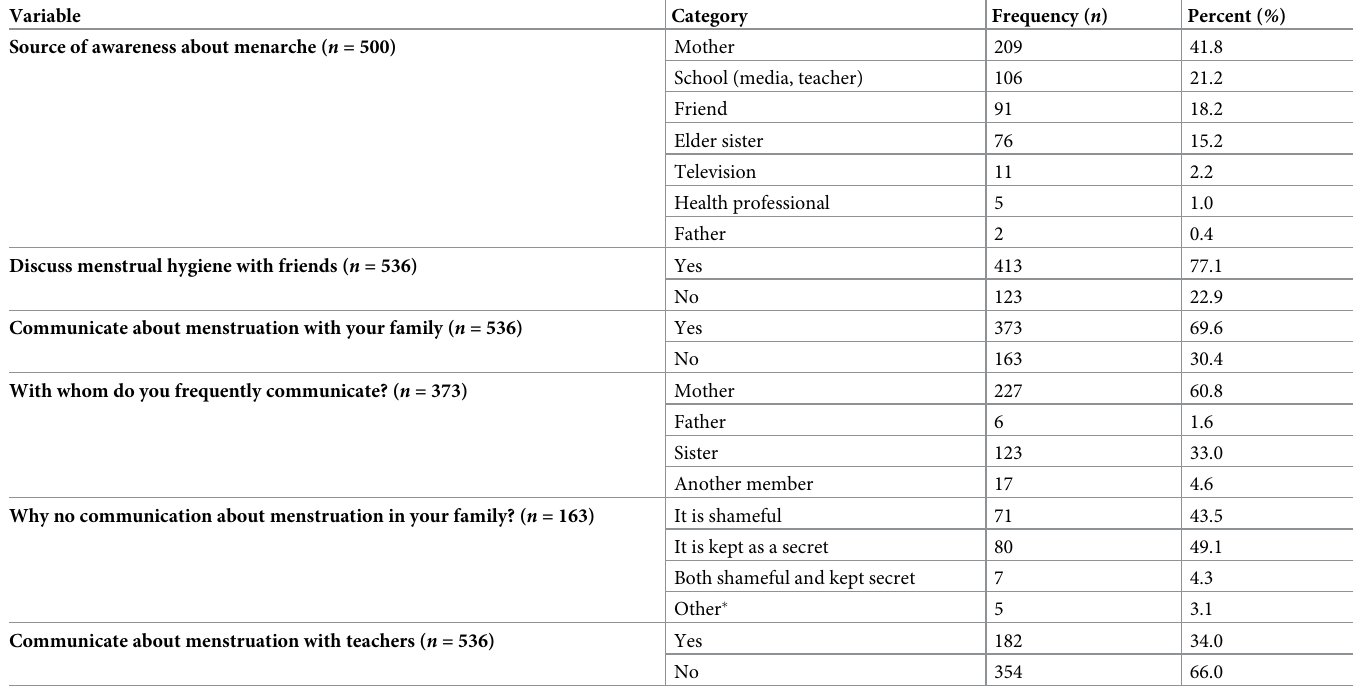
Table 4. Source of information and communication about menstruation among high school girls of Dessie City, Amhara Region, northeastern Ethiopia, 27 January to 6 March 2020. Variable